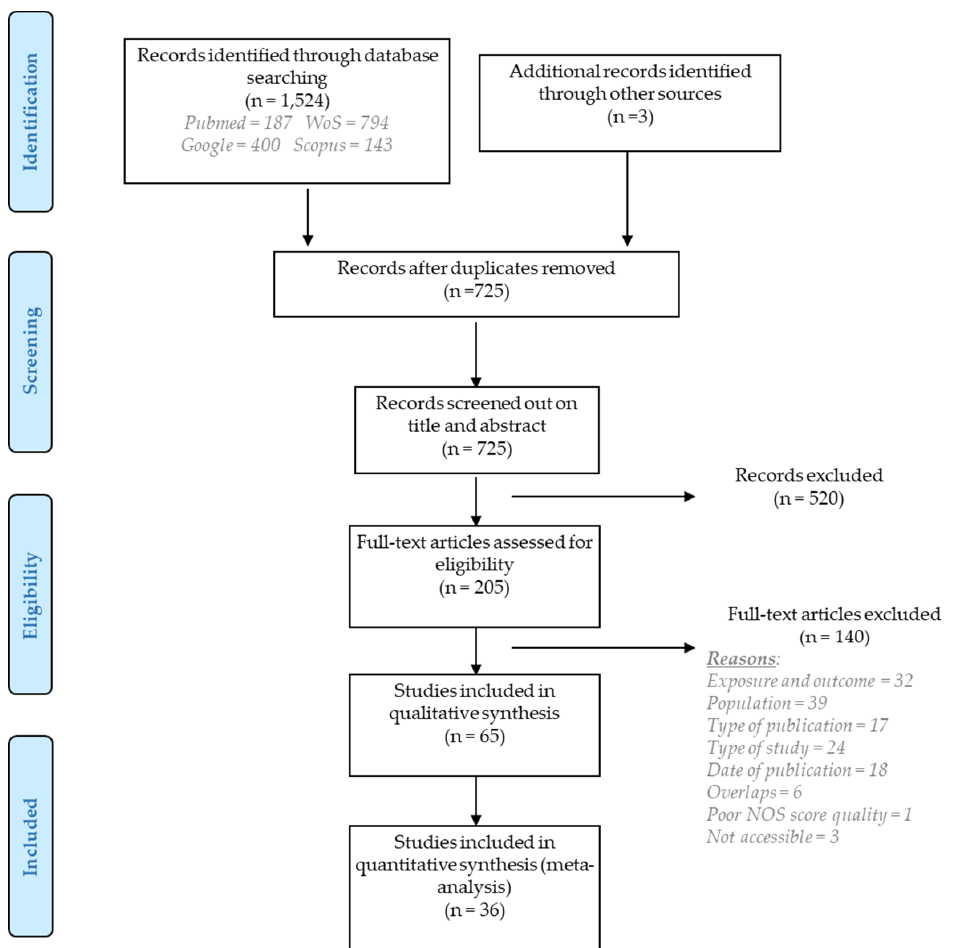
Figure 1. PRISMA flow diagram for the results of literature search, screening, and selection of relevant